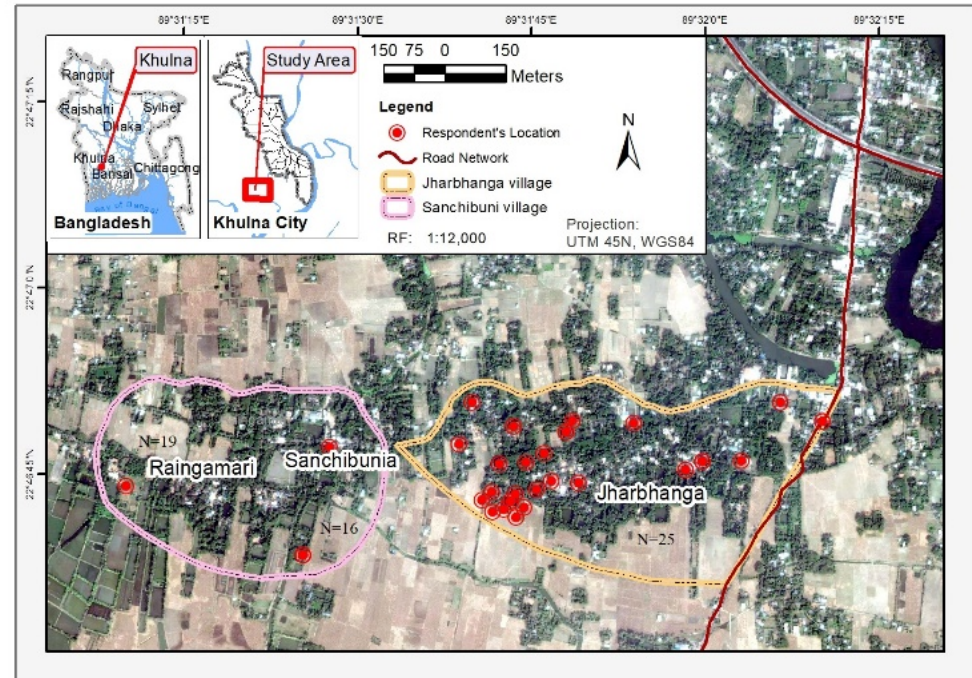
Figure 1. General location of the study area with point location of the sampled households or surveyed village locations in Batiaghta Upazila in periurban Khulna Bangladesh. At Jharbhanga village interviews (N = 25) were conducted at individual farmers’ households. At Sanchibunia and Raingamari villages, interviews (N = 16 + 19 = 35) were conducted at three village points of the farmers’ households.